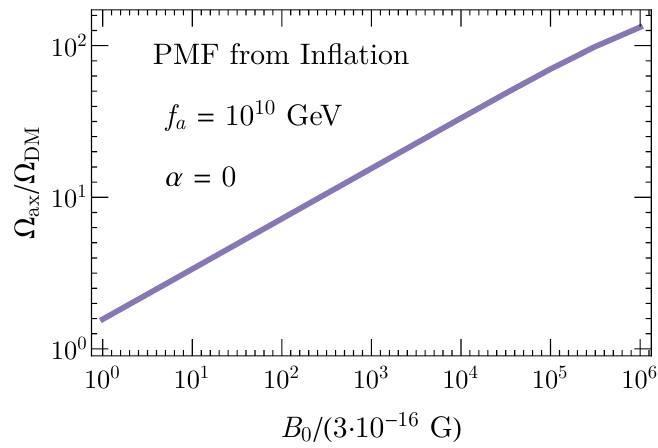
Figure 8 . For inflationary PMF, Ω ax / Ω DM as a function of B 0 today, scaled by the observed lower bound B 3 · 10 − 16 G. f is taken to be 10 10 min ≡ a